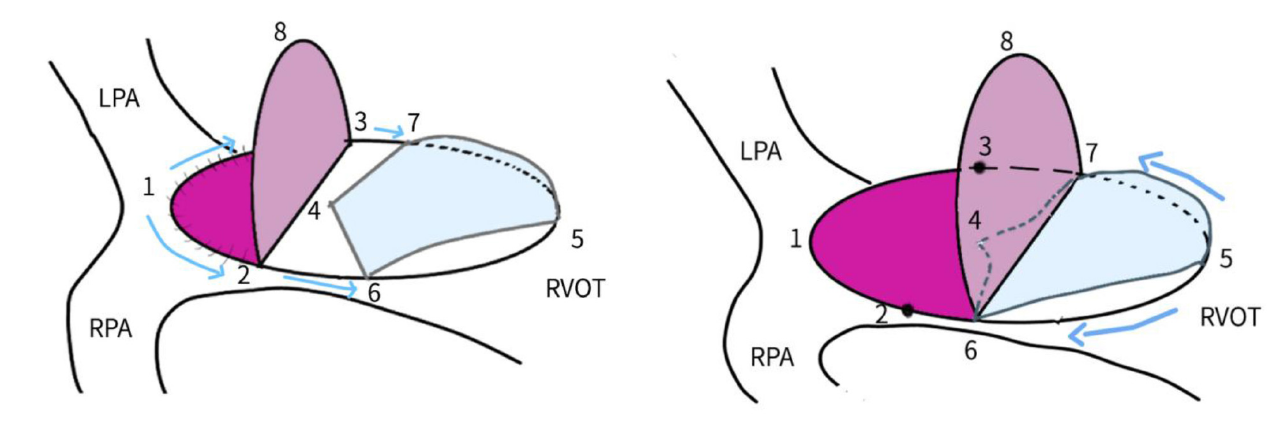
Fig. 1C – Pericardial patch augmentation started at the distal end artery; PTFE=polytetrafluoroethylene; RPA=right pulmonary artery; RVOT=right ventricular outflow